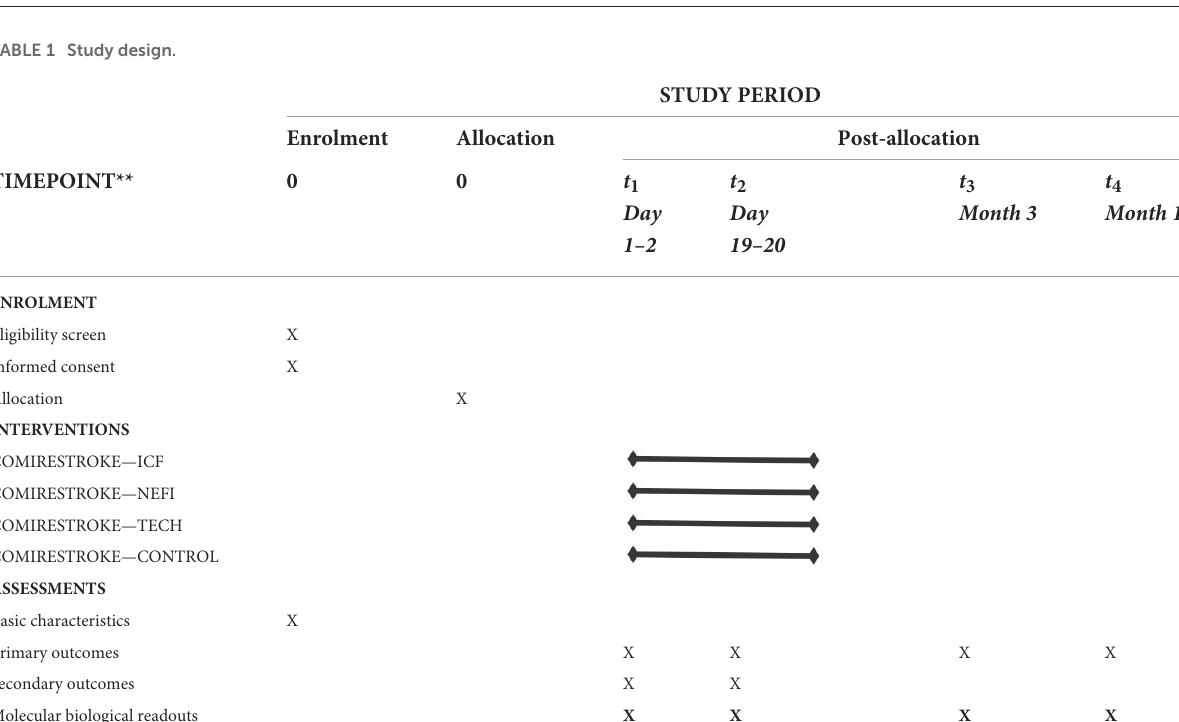
FIGURE1 Study design.